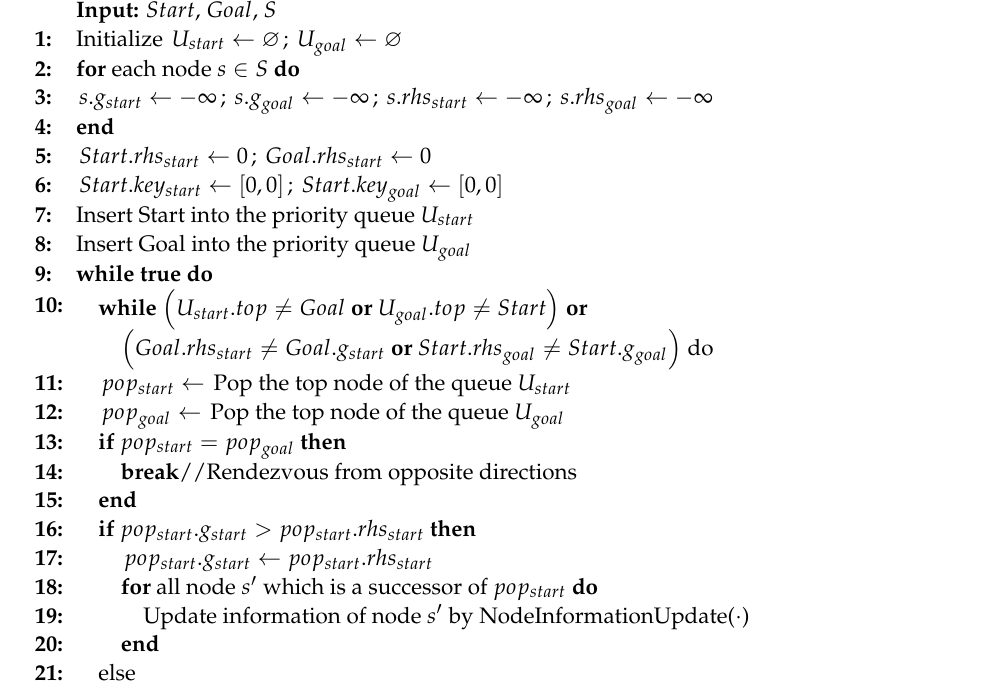
Algorithm 1. Bidirectional, InCremental A* Path Selection Algorithm